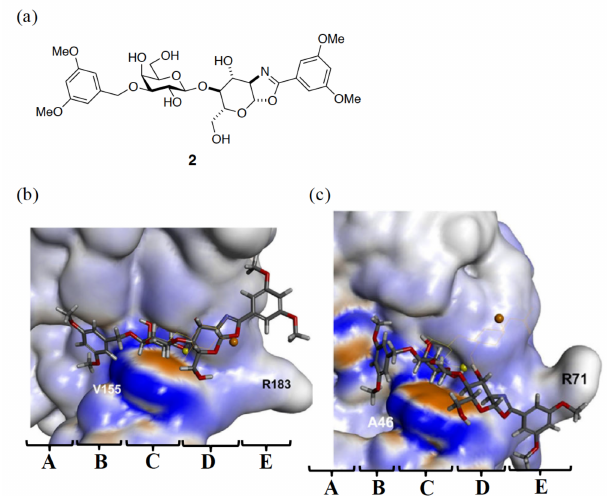
Figure 8. ( a ) Molecular structure of 1,2-fused (3,5-dimethoxyphenyl)-oxazoline-substituted LacNAc (compound 2 ). ( b , c ) Postulated binding mode of 2 with GAL-3 and -7, respectively. The binding interactions were generated by the CDOCKER docking protocol using Discovery Studio version 4.1. Reprinted with permission from © 2017 Wiley-VCH Verlag GmbH & Co [61].